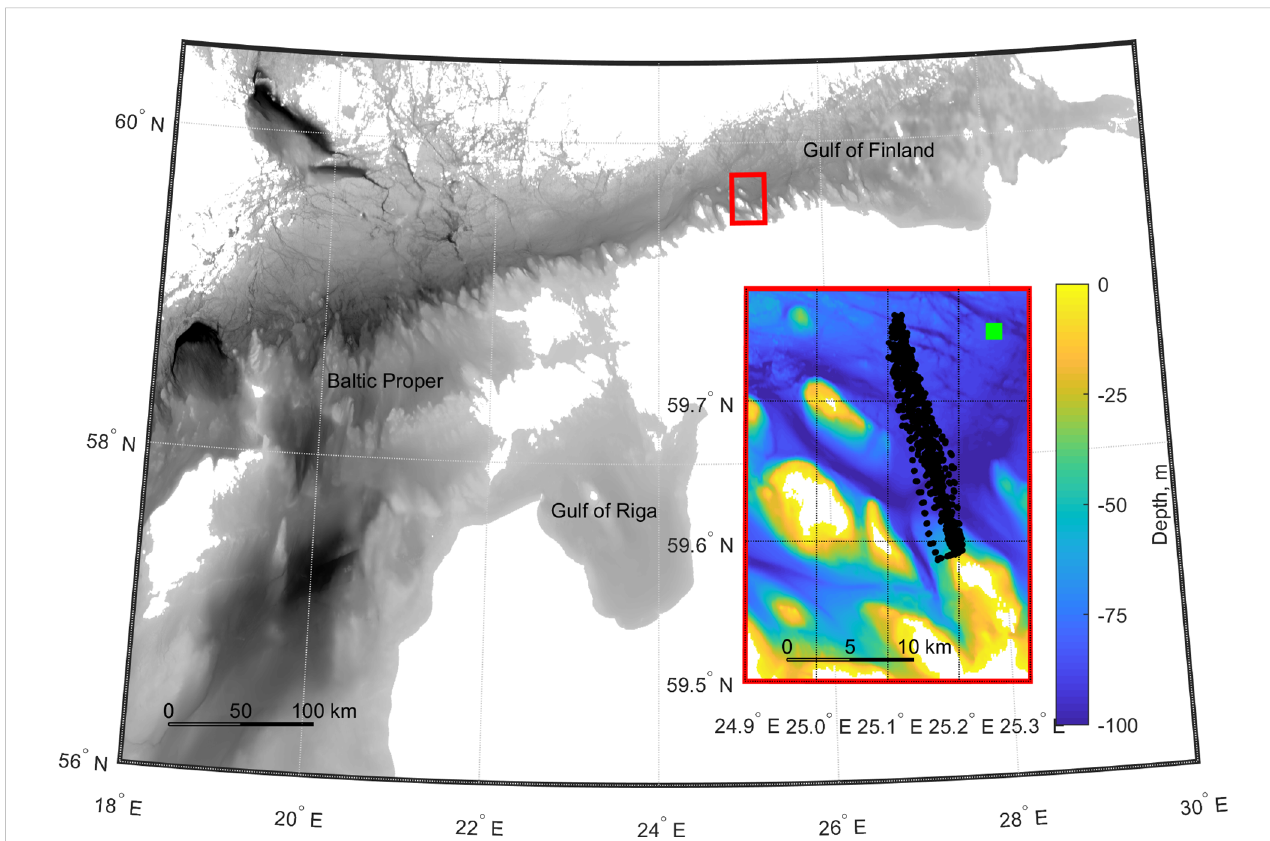
FIGURE 1 Map of the study area in May 2018. The overlaid plot shows the bathymetry (EMODnet digital terrain model) of the deployment area highlighted by a red rectangle. Black dots indicate the glider in fl ections on the surface. The green square shows the position of the ERA5 grid point used for the wind